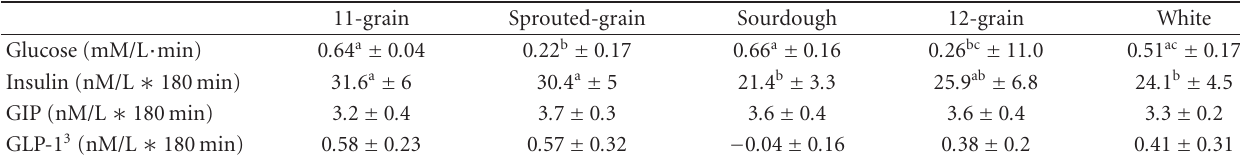
Table 3: Incremental area under the curve for blood glucose, serum insulin, plasma GIP and GLP-1 after ingestion of 50g available CHO of the test breads for 180 min (part 1) 1,2 .